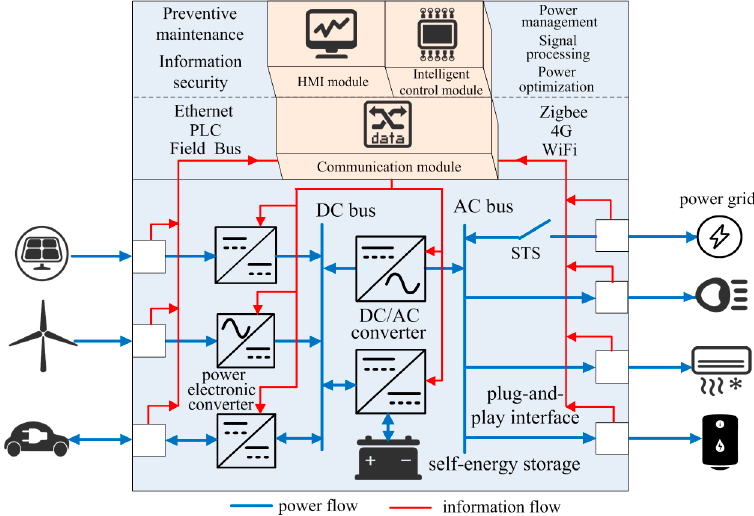
Figure 2. Configuration of energy router-based HEMS.